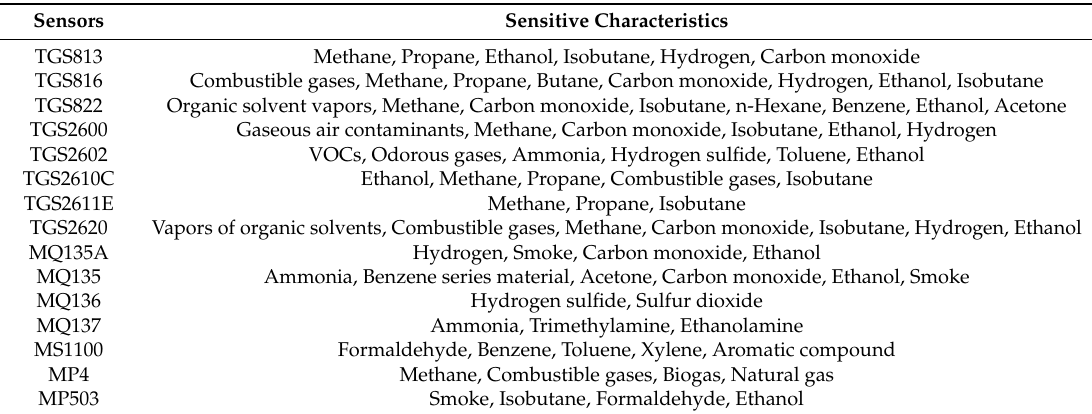
Table 2. The main sensitive characteristics of gas sensors.